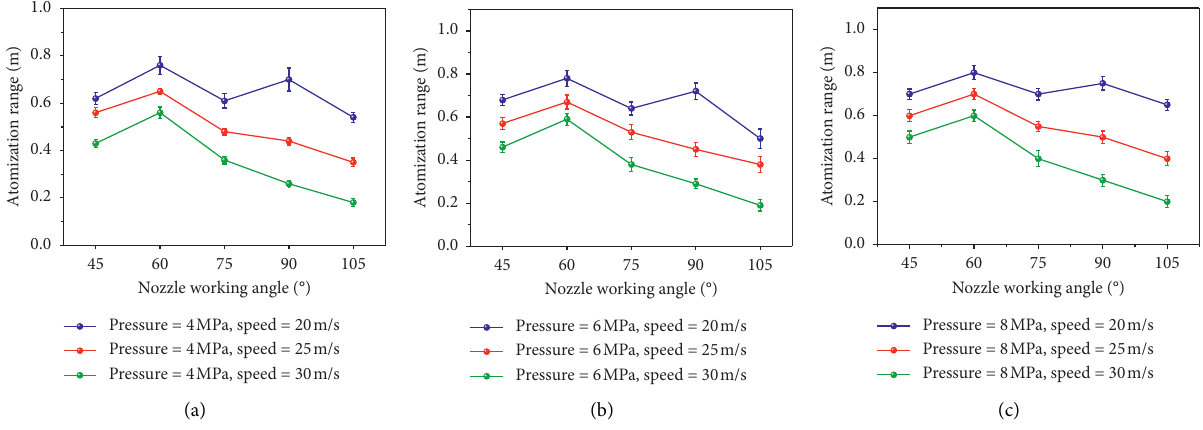
Figure 10: Atomization range at different pressures: (a) pressure 4 MPa, (b) pressure 6MPa, and (c) pressure 8MPa.